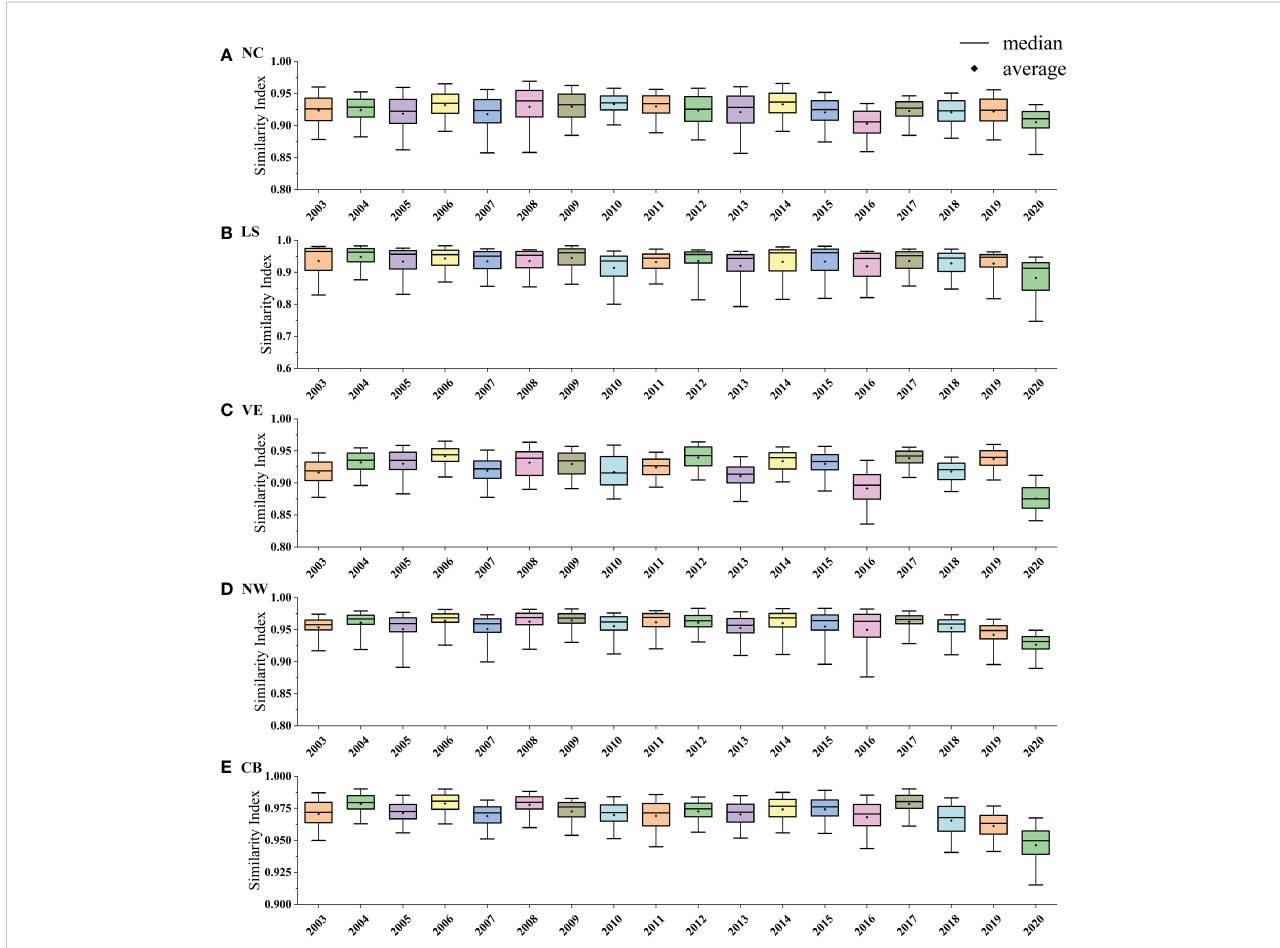
FIGURE 6 Quartile diagrams of similarity index between the seasonal variation of NPP for each year (2003 – 2020) and monthly climatology mean in typical regions: (A) NC, (B) LS, (C) VE, (D) NW and (E) CB. The rectangles, black lines, and black dots indicate the interquartile range, average, and median,